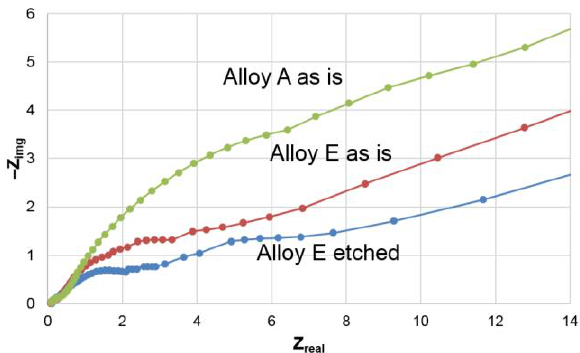
Figure 6. Cole-Cole plots obtained from room temperature alternative current (AC) impedance measurements of A (as-is only) and E (both as-is and etched).